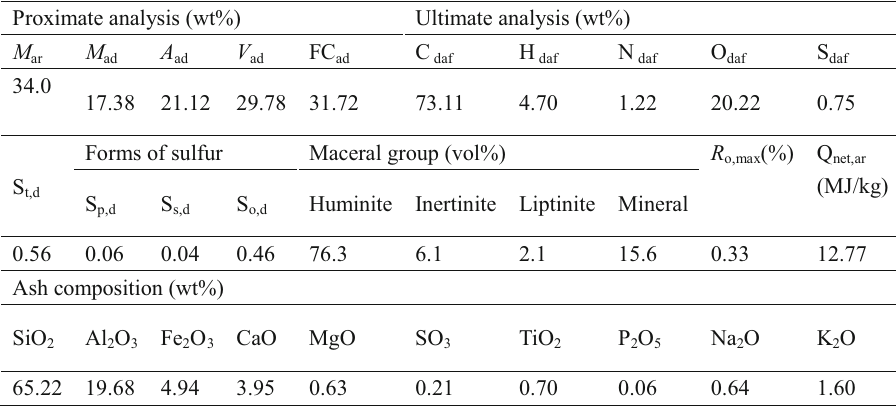
Table 1 Basic characteristics of the coal studied Proximate analysis